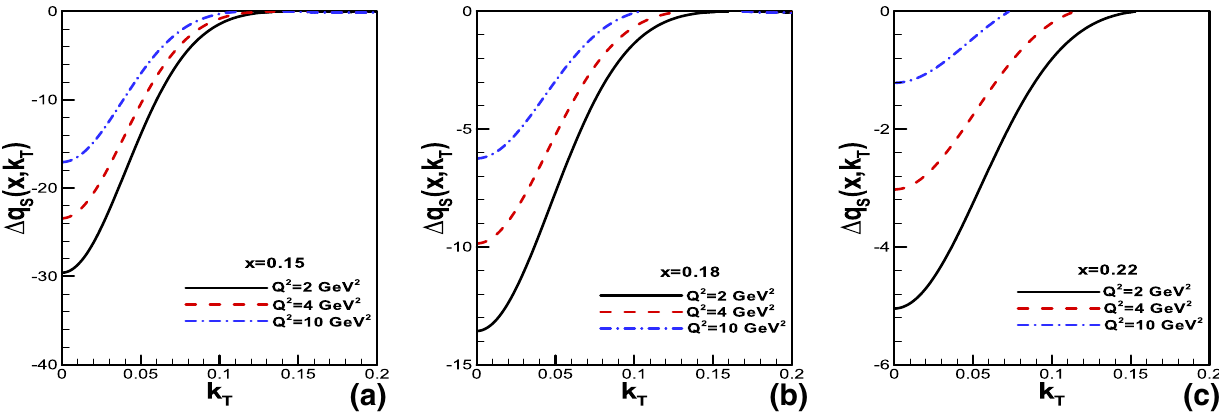
Fig. 16 The k T -distribution of total polarized sea quarks at a x = 0 . 15, b x = 0 . 18 and c x = 0 . 22. The TMD polarized sea distributions are plotted at three values of Q